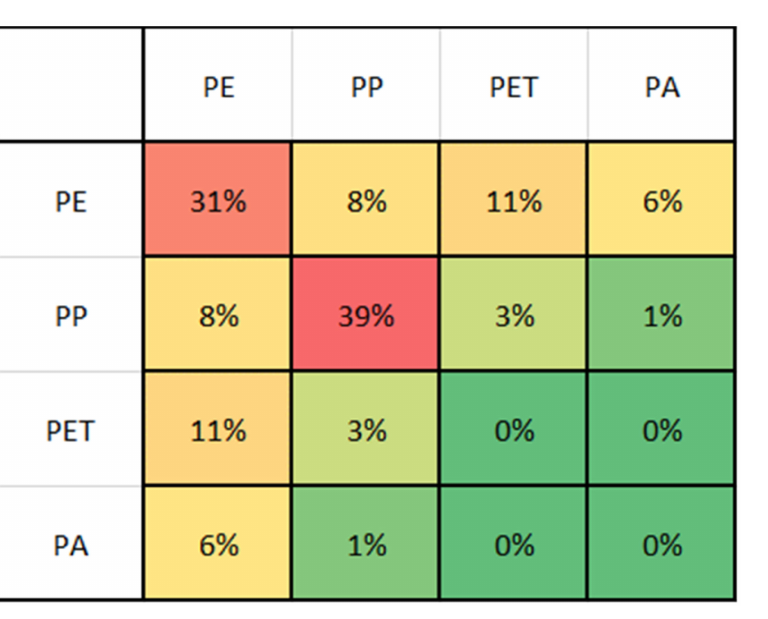
Figure 5. Composition of the small films according to the material class colour-coded to represent the highest proportion ( red ) to the lowest proportion ( green